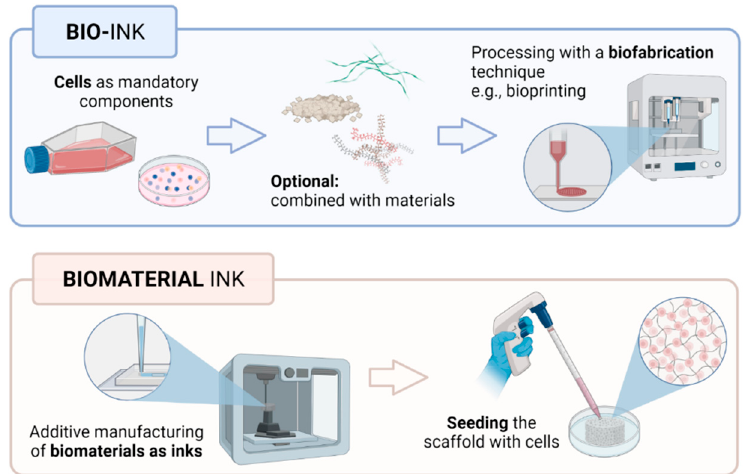
Figure 6. Distinction between a bio-ink (i.e., cell-laden) and a biomaterial ink (i.e., cell-free). In bio-inks ( upper image), cells are intrinsic components of the printing formulation (e.g., seeded onto microcarriers, embedded in microgels, formulated in a physical hydrogel or formulated with hydrogel precursors). In biomaterial inks ( bottom image), cells are introduced within the 3D bioprinted biomaterial scaffold, reducing the biological constraints on the inks (created in BioRender.com, adapted from Groll et al., 2018 [82]).